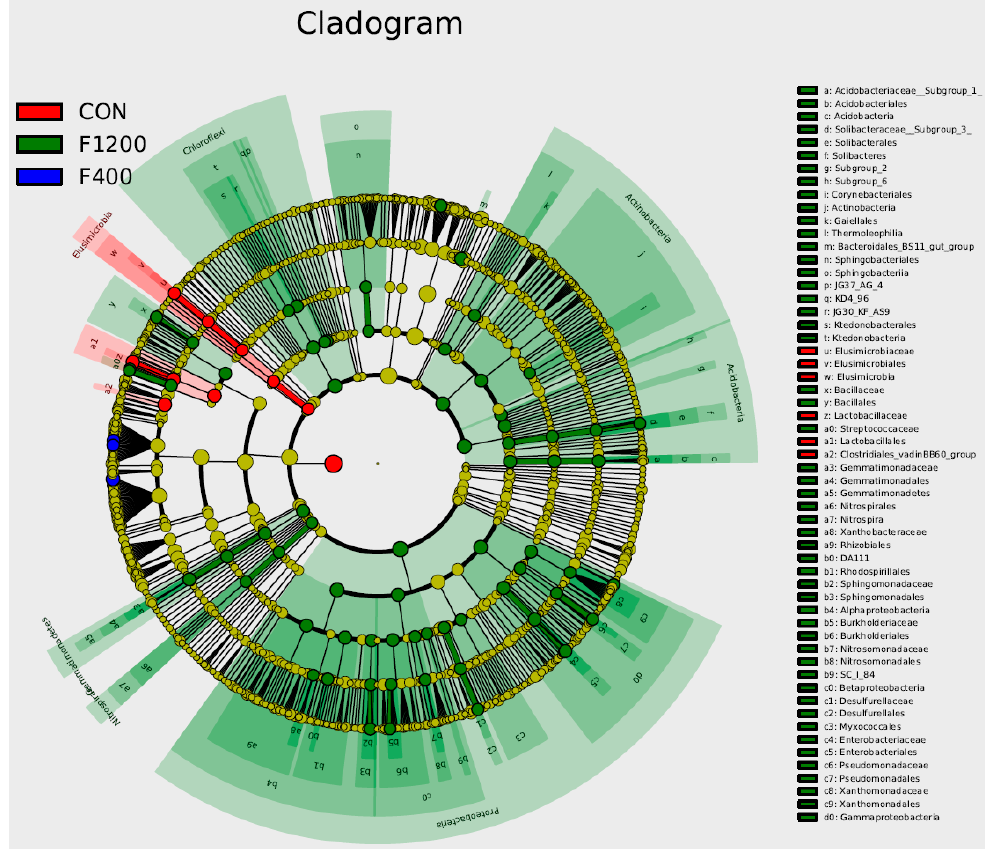
Figure 7. Cladogram representation of the di ff erentially abundant families and genera (only top 50% are plotted here, n = 5). The root of the cladogram indicates the domain bacteria. The taxonomic levels of phylum and class are marked, while family and genus are abbreviated, with di ff erent colors indicating the group hosting the greatest abundance. The size of each node represents its relative abundance. CON, the control group, basal diet; F400 and F1200, diets supplemented with 400, and 1200 mg F / kg feed from sodium fluoride, respectively.